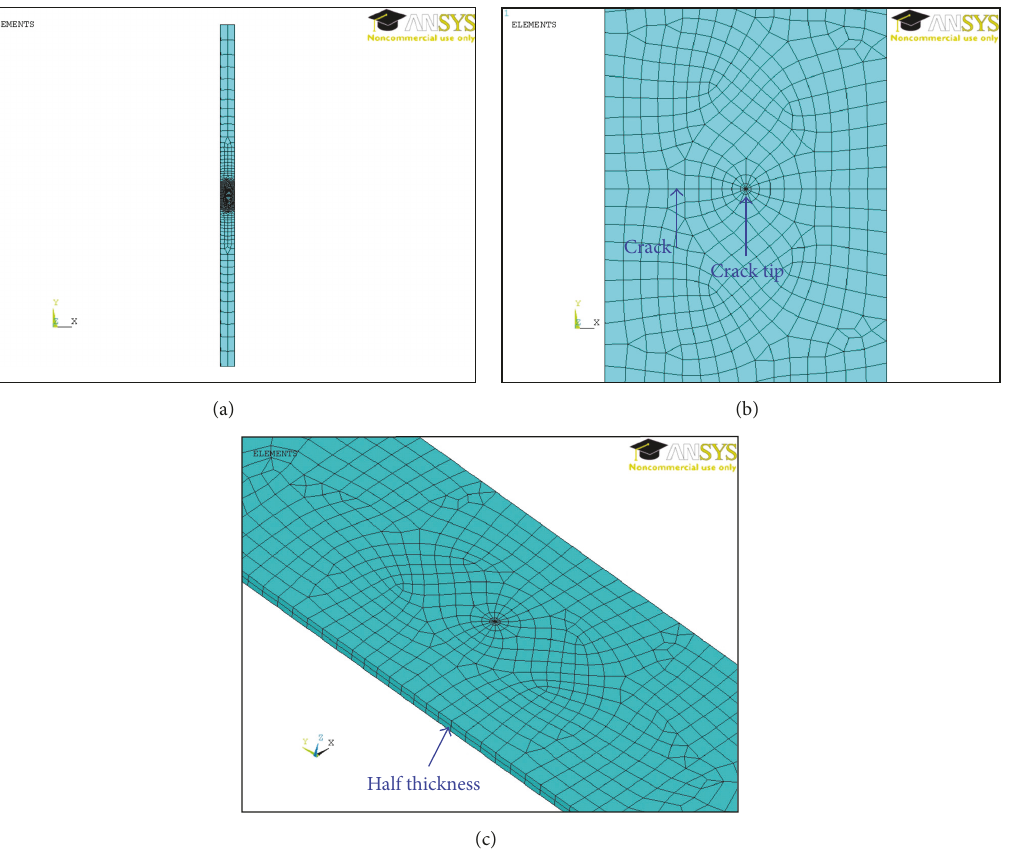
Figure 4: Finite element model. (a) Entire view of plate, (b) local region near crack, and (c) three-dimensional view.